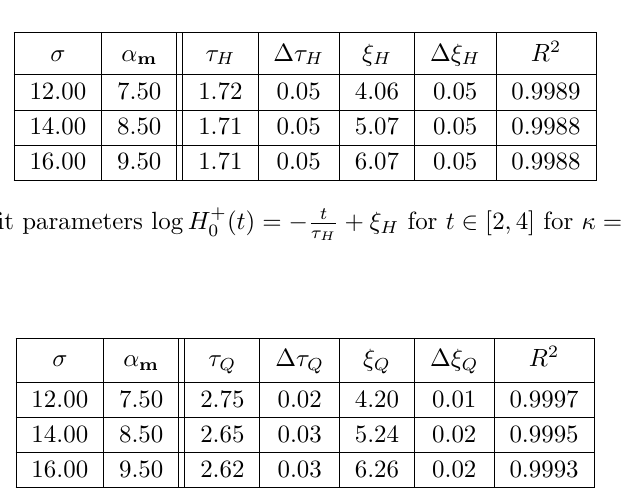
Table 6 . Linear fit parameters log Q +